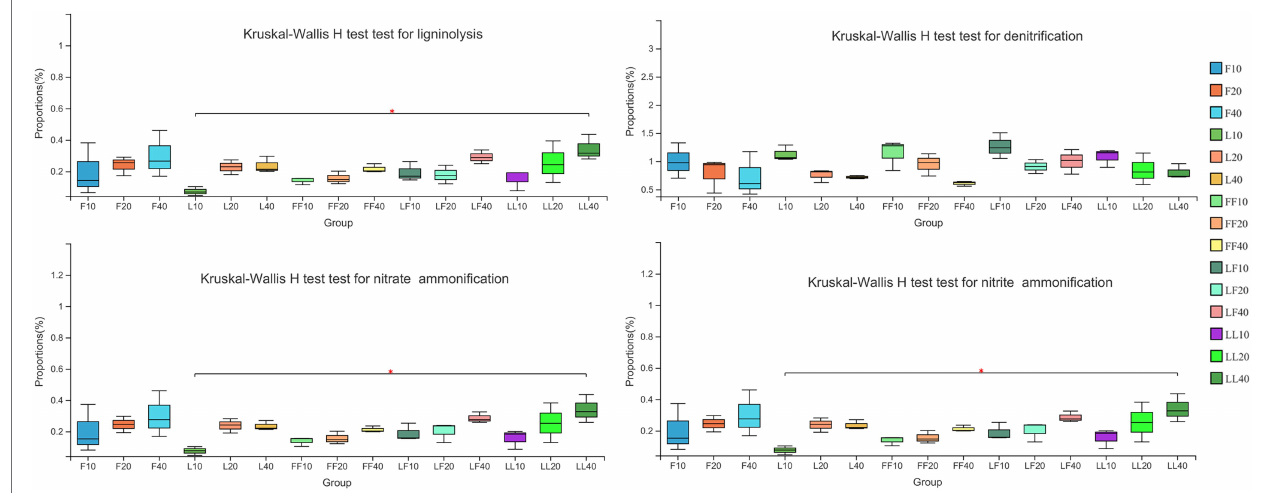
FIGURE 4 | Functional bacterial community categories involved in nutrient cycling function. Error bars show standard errors of the mean ( n = 3). Refer to Figure 1 legend for relevant abbreviations.